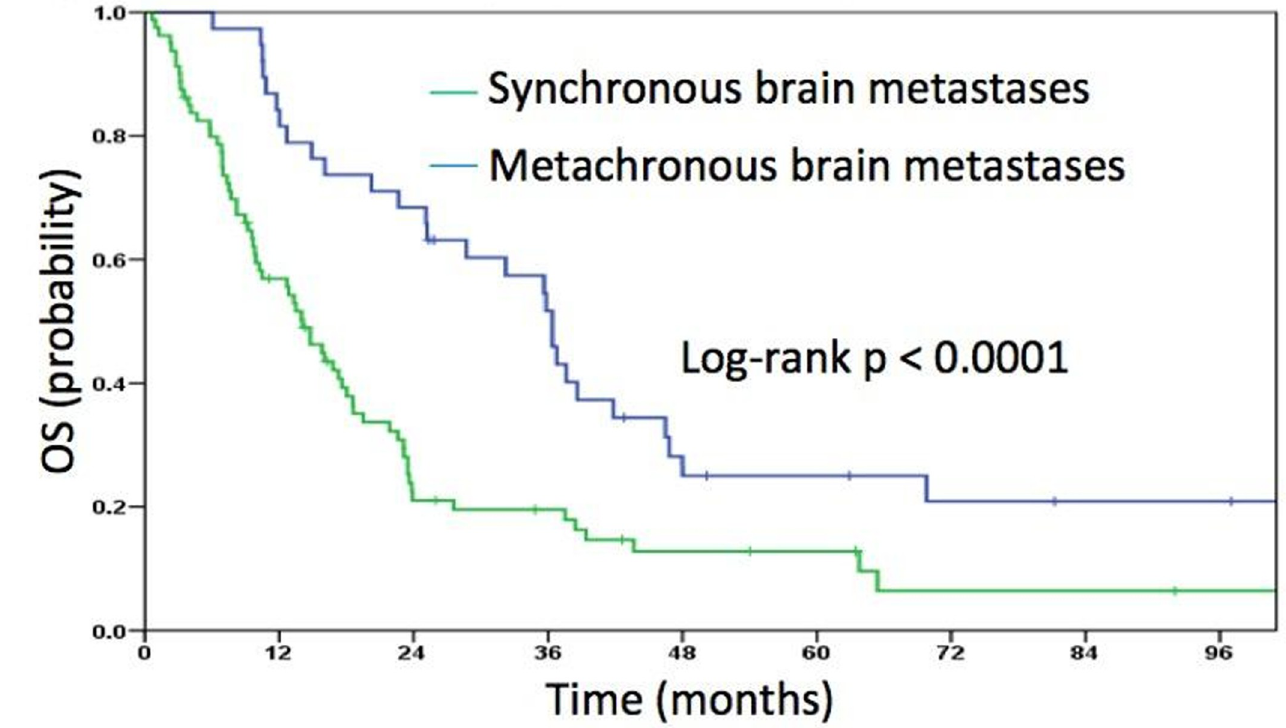
Fig 3. Overall survival for patients with synchronous and metachronous